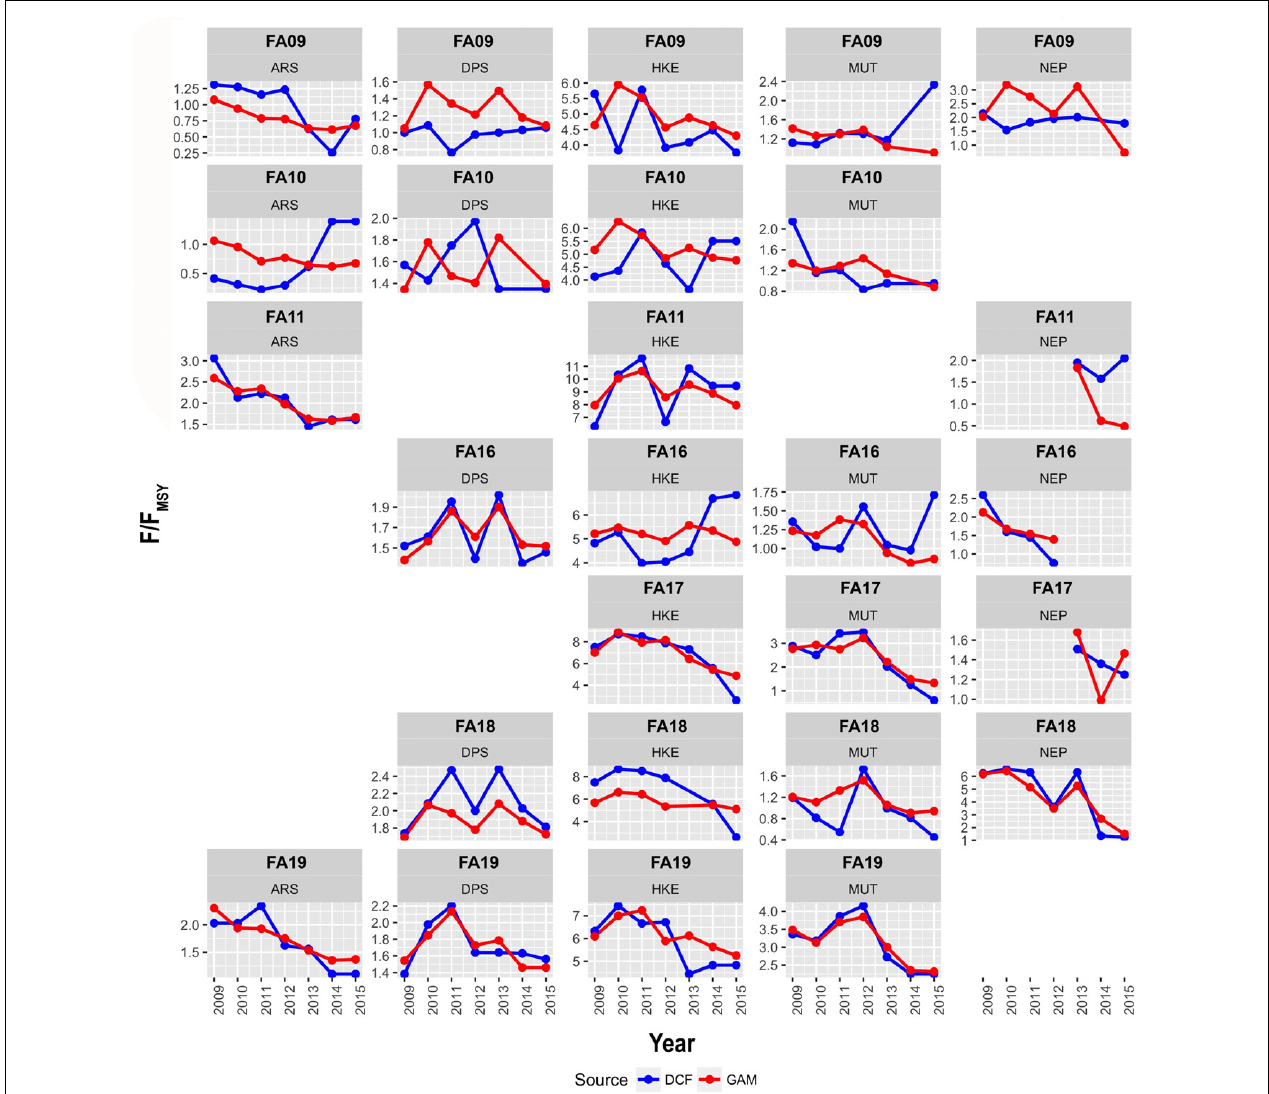
FIGURE 10 | Comparisons between actual trends (source: DCF, blue lines and dots) and GAM-based models (red lines and dots) of the ratio F/FMSY, during the period